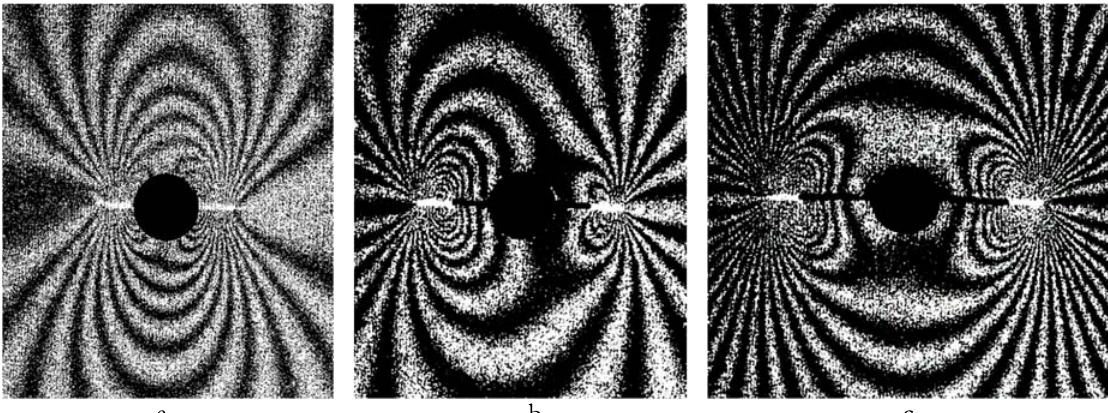
Figure 2: Interference fringe patterns obtained in terms of in-plane displacement component v for specimen